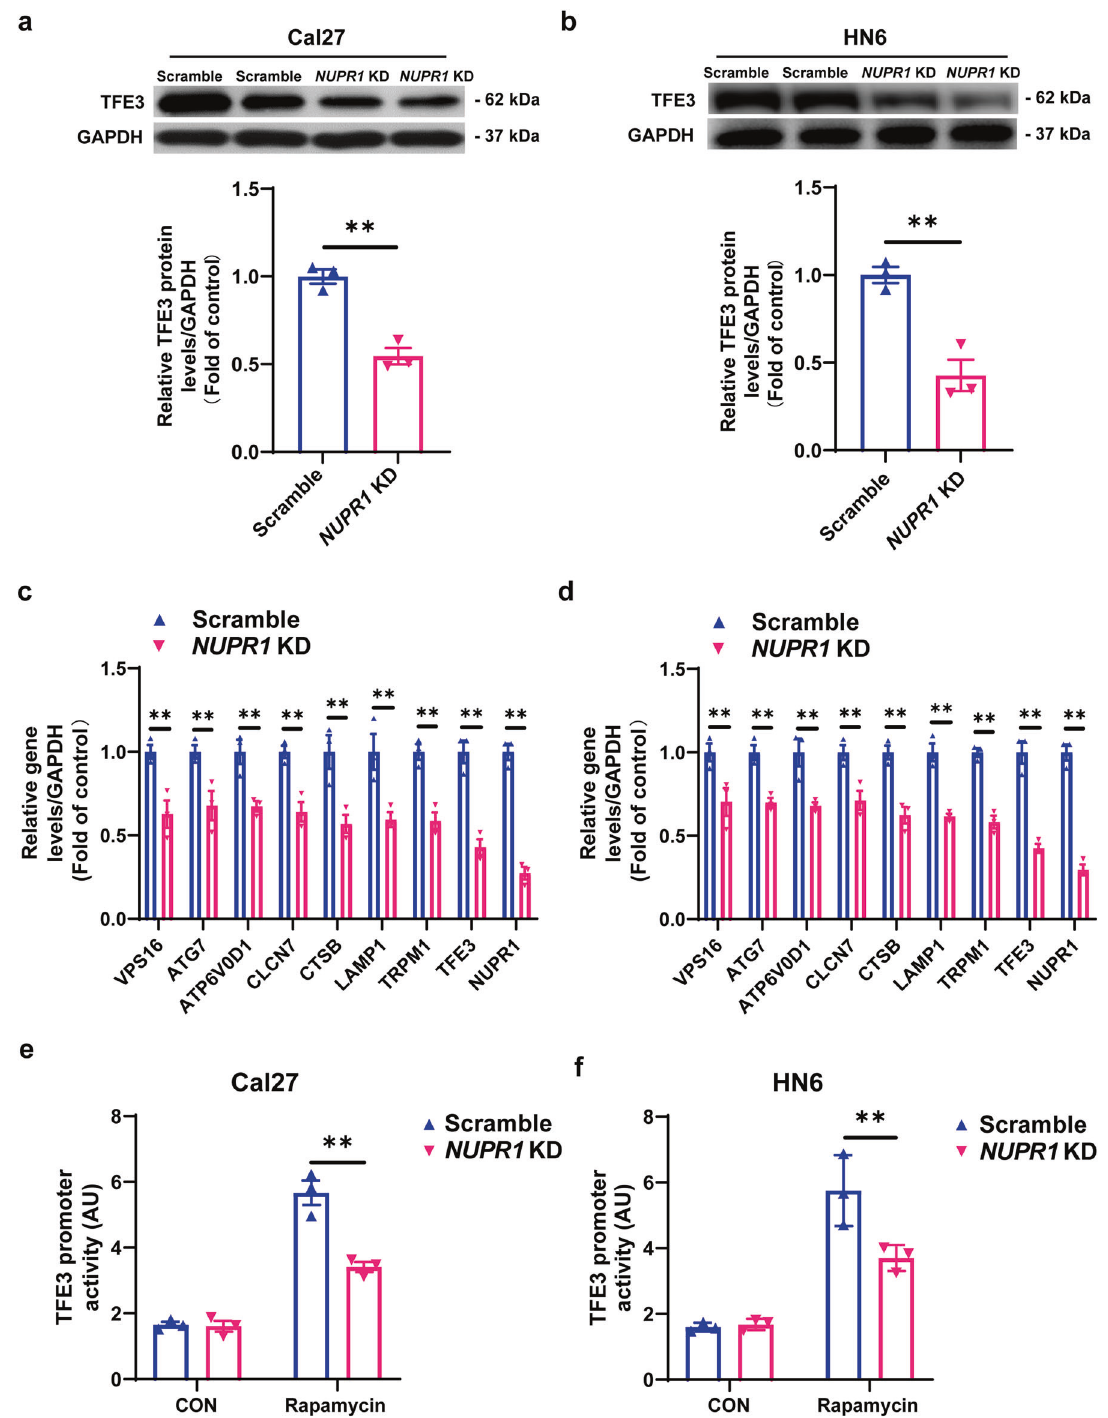
Fig. 3 TFE3 was required for NUPR1-mediated autolysosomal processes in OSCC cells. a , b Immunoblotting analysis of TFE3 in NUPR1 KD or scrambled Cal27 and HN6 cells; n = 3. c , d The results of TFE3 -responsive genes involved in autophagic fl ux were detected by real-time PCR in NUPR1 KD or scrambled Cal27 and HN6 cells; n = 3. e , f TFE3 transcription activities involved in autophagic fl ux were detected by Secrete-Pair luminescence assay in NUPR1 KD or scrambled Cal27 or HN6 cells; n = 3; ** P < 0.01 vs. the scrambled group therapeutic target of NUPR1-TFE3-dependent autophagy in OSCC formation or maturation, and autophagosome-lysosome fusion) is progression. a crucial cause of NUPR1 KD -induced autophagic fl ux impairment Most tumour tissue specimens archived in hospitals for and inhibition of OSCC cell proliferation and metastasis. (iii) NUPR1 pathologic diagnosis are FFPE specimens, which represent the maintained autophagic fl ux by increasing TFE3 promoter activities pinpoints of tumour tissue and generally contain rich clinical data. and activating TFE3 transcription in OSCC progression. These fi ndings, therefore, broaden new insights regarding a potential Proteomics is an ef fi cient tool to investigate discrepancies in Signal Transduction and Targeted Therapy (2022)